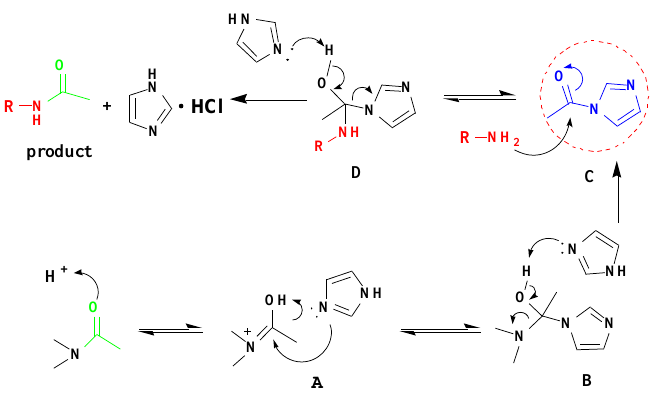
Scheme 2 . Plausible mechanism for N -acetylation using imidazolium chloride catalyst.